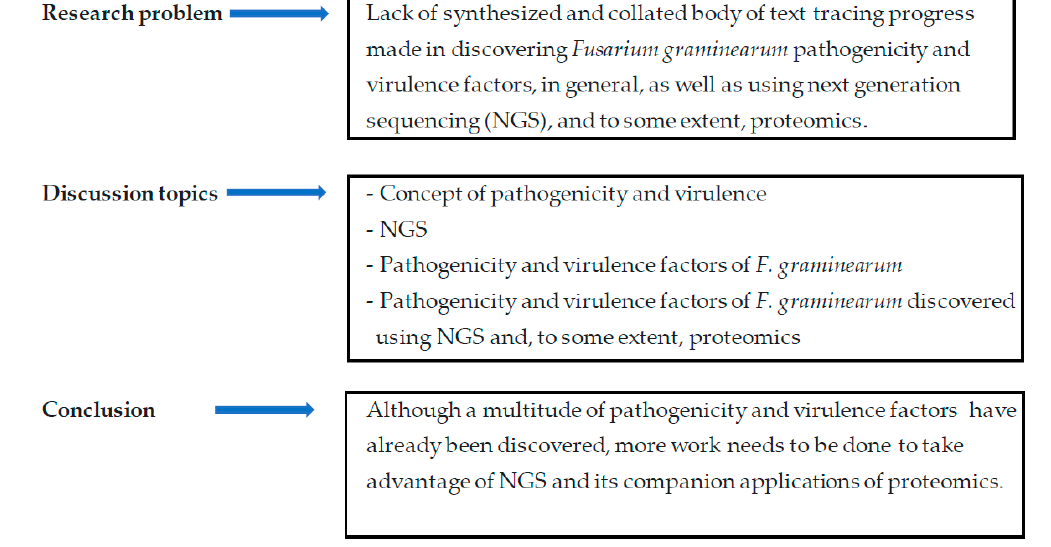
Figure 2. An illustration of concept development and the organization of the article.